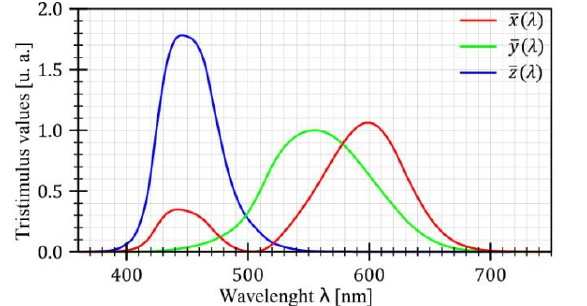
Figure 1. XYZ Colour Matching Functions (CMF) of CIE 1964 standard observer.